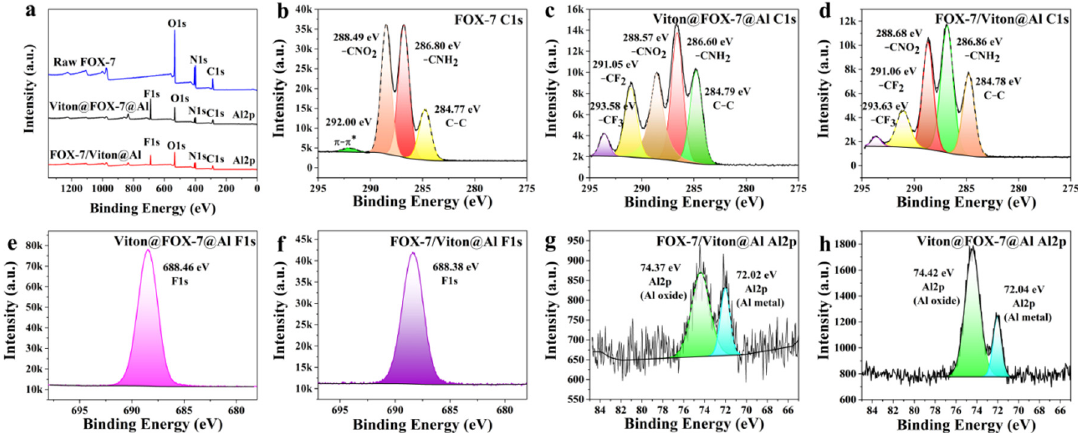
Figure 3. ( a ) XPS survey spectra of the three samples; The detailed spectra of the C1s peaks for ( b ) recrystallized FOX-7; ( c ) FOX-7/Viton@Al and ( d ) Viton@FOX-7@Al; the detailed spectra of the F1s peaks for ( e ) FOX-7/Viton@Al and ( f ) Vi-